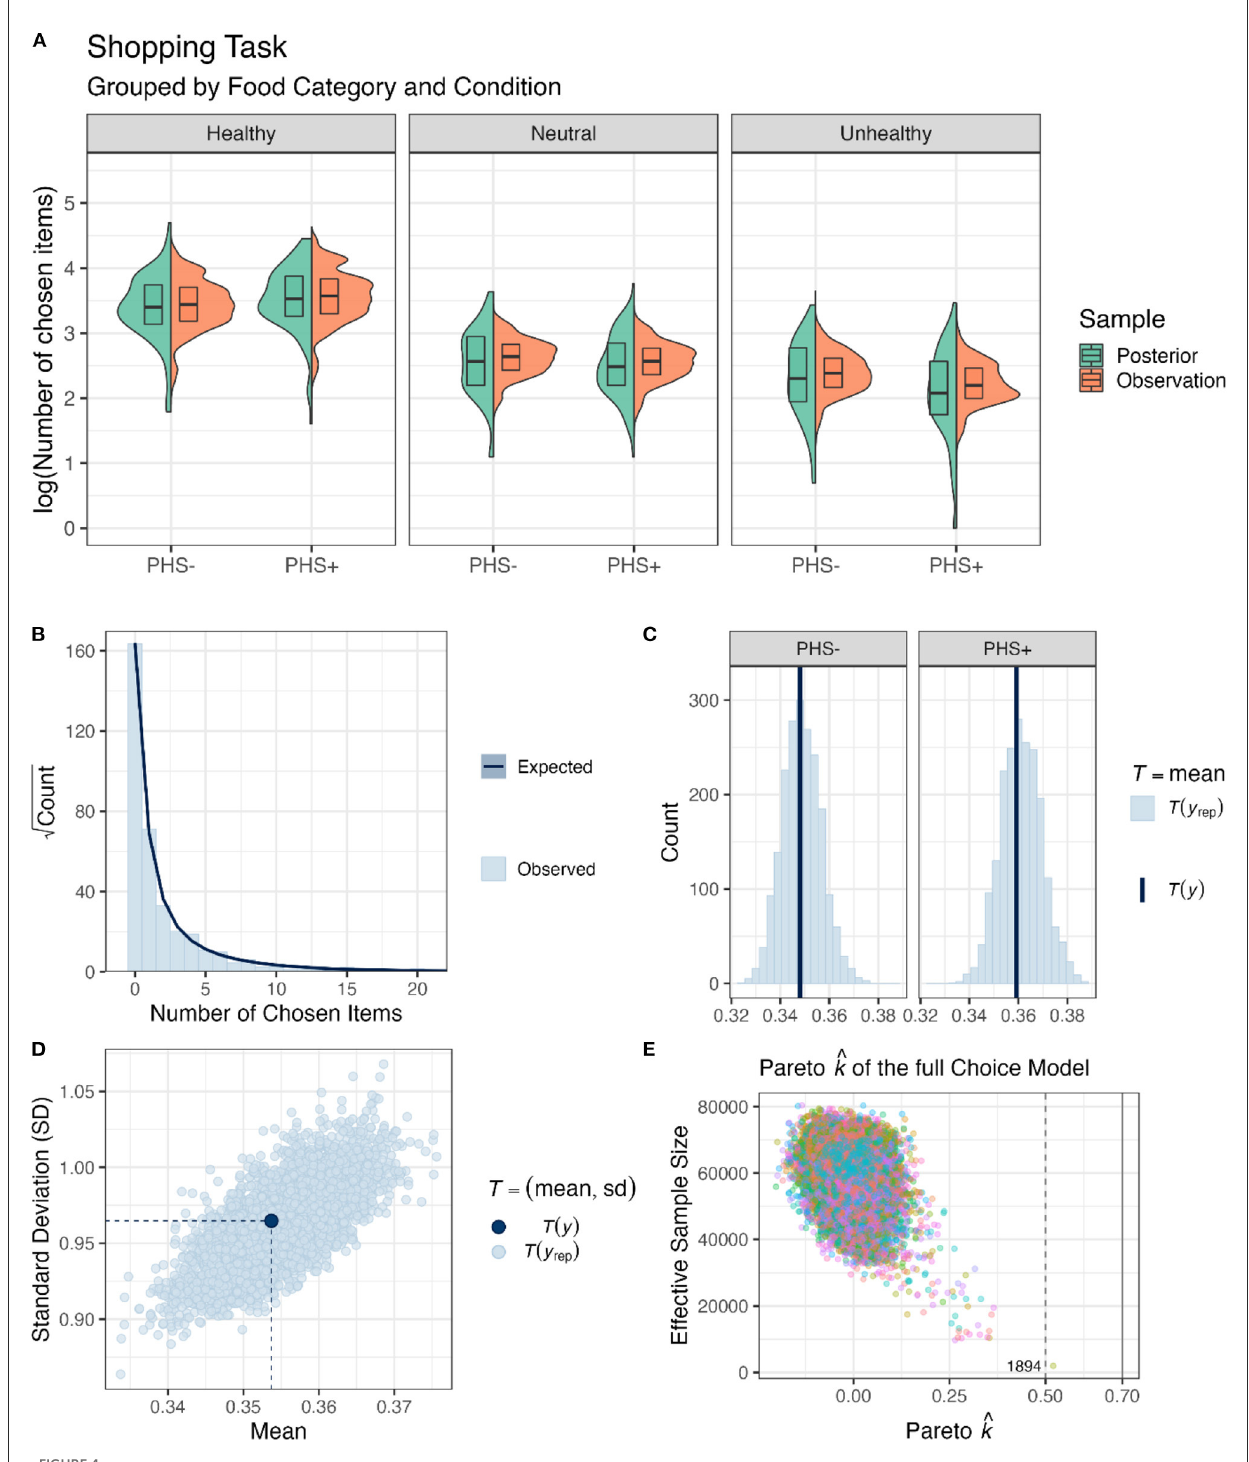
FIGURE4 Food choice behavior in the online supermarket task. (A) Box and violin plots of the average sum of chosen items per participant, food category, and PHS condition on the log scale (pooled over Session). Note that the data was curated for plotting purposes, as first, the choices were averaged for each health category and participant, and then the log of these values was plotted here. (B) A bar plot of the data obtained from the shopping task depicting the distribution of the observations. The dark blue line and shadows represent mean and standard error estimates obtained from posterior distributions. (C) Frequency density bar plots showing the estimated ( y rep ) and observed mean numbers of items chosen ( y ) in the two PHS conditions. (D) A scatter plot showing the diffusion of choices. Light blue dots ( y rep ) are estimated based on posterior distributions, and the dark blue dot ( y ) is the observed value. (E) Pareto ˆ k values for the full Choice Model are depicted against the effective sample sizes for importance sampling. If leaving out an observation changes the posterior too much, then PSIS-loo is not able to give a reliable estimate (Vehtari et al., 2016; Magnusson et al., 2020). However, in the current model and sample, there was no value over 0.7 and only one value over 0.5, which is annotated with the